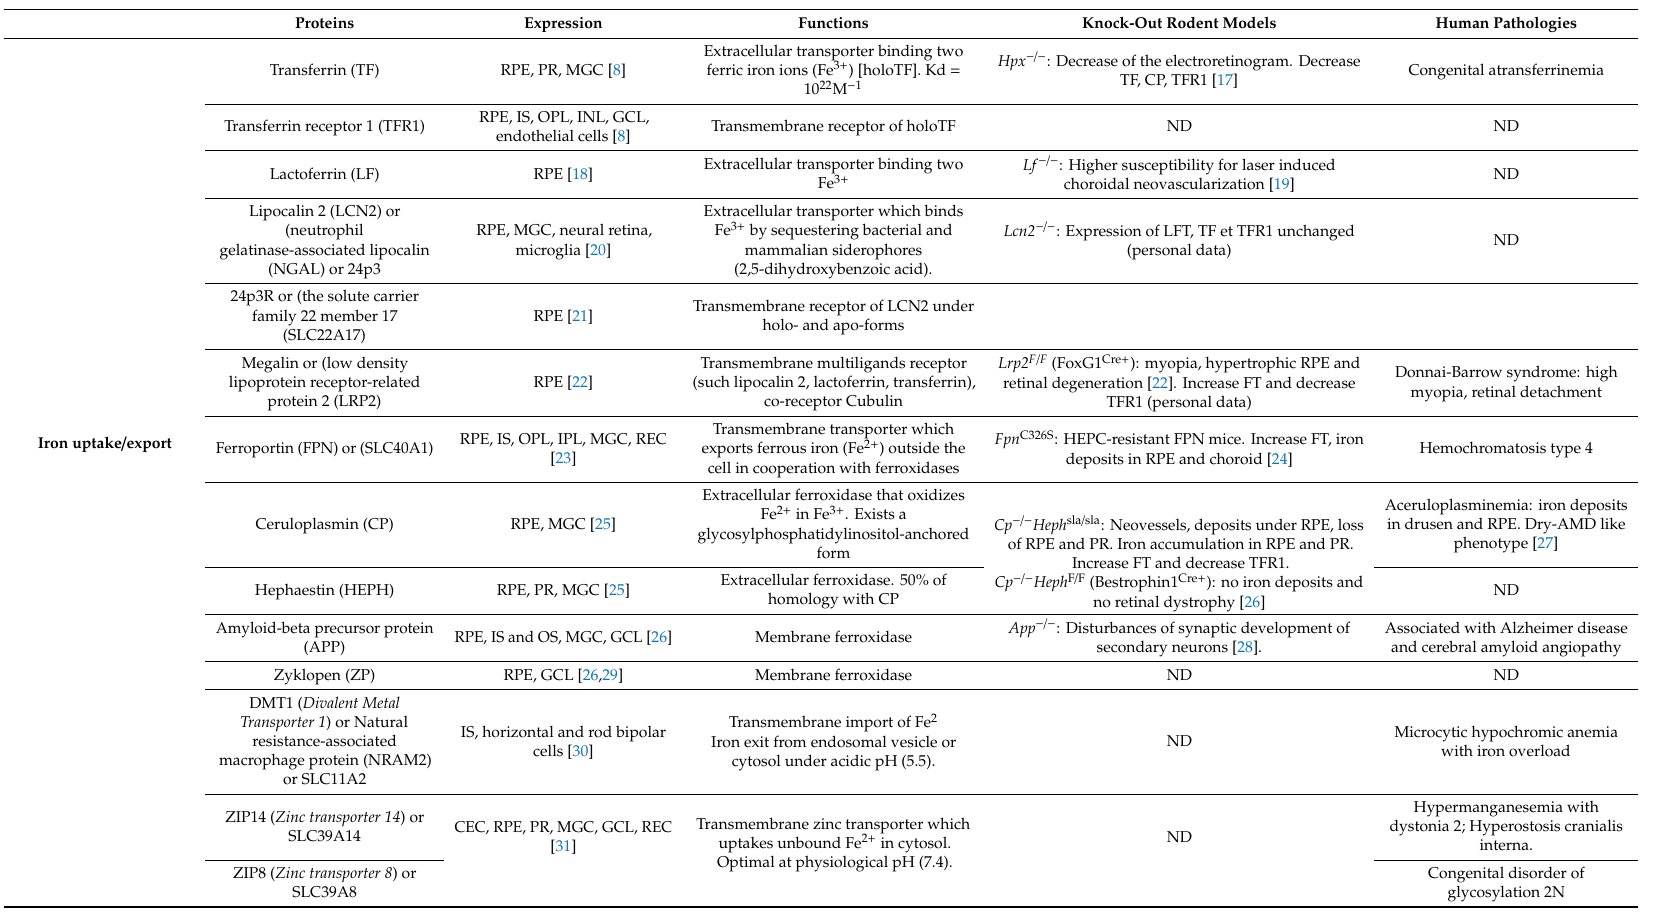
Table 1. Proteins involved in iron homeostasis of the